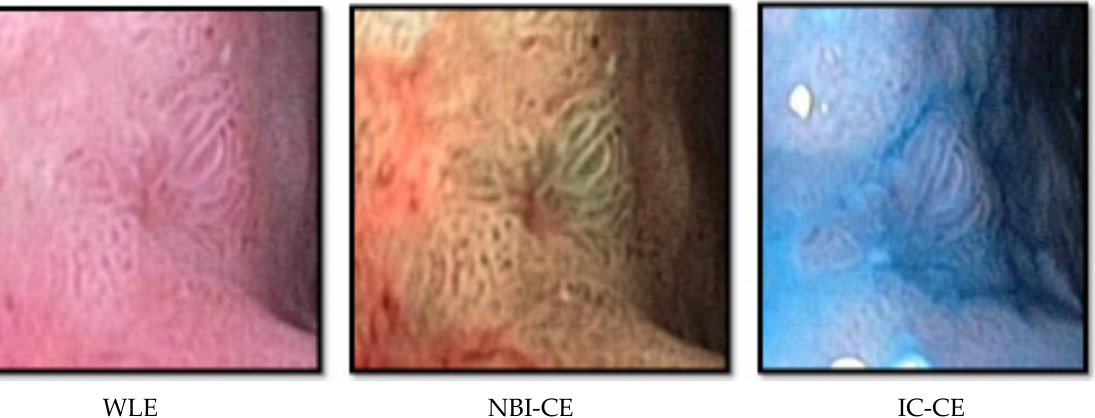
Figure 2. Sample images of the same focal change in Dog 6, as seen at regular white light endoscopy (WLE), narrow band imaging chromoendoscopy (NBI-CE) and indigo carmine chromoendoscopy (IC-CE). Histology revealed mucous metaplasia and glandular dysplasia.